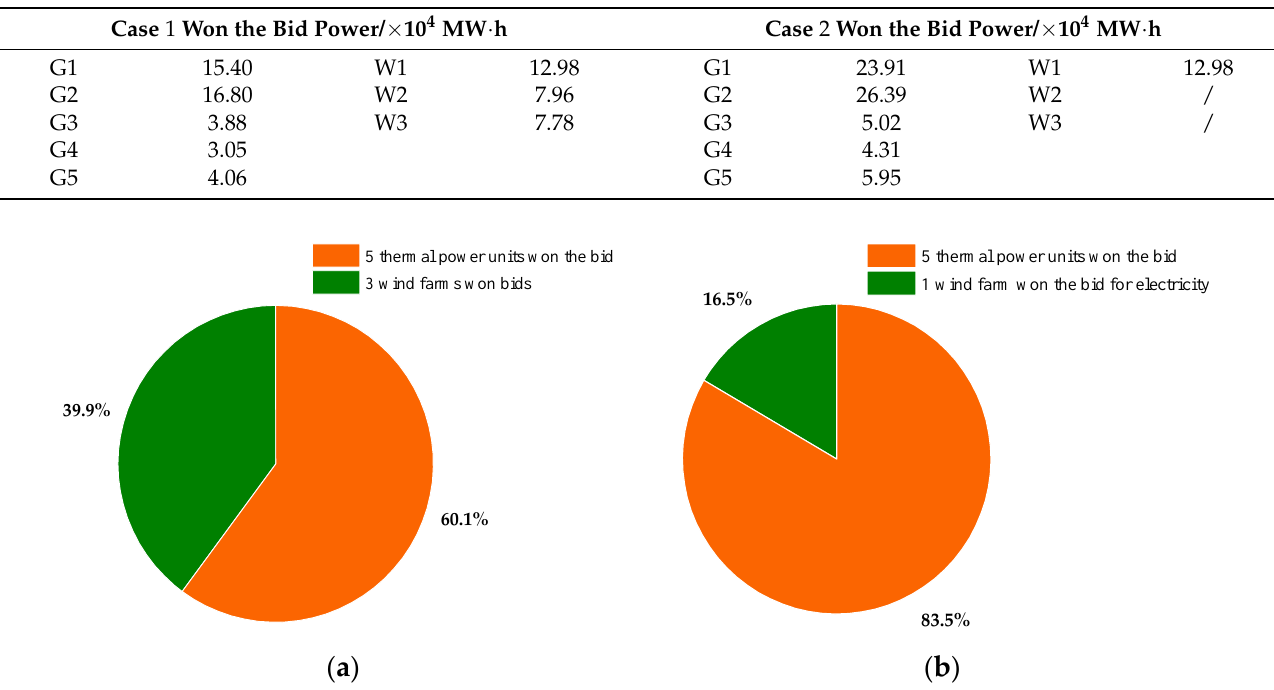
Table 3. Wind-Fire Electric Bidding Transaction Results.